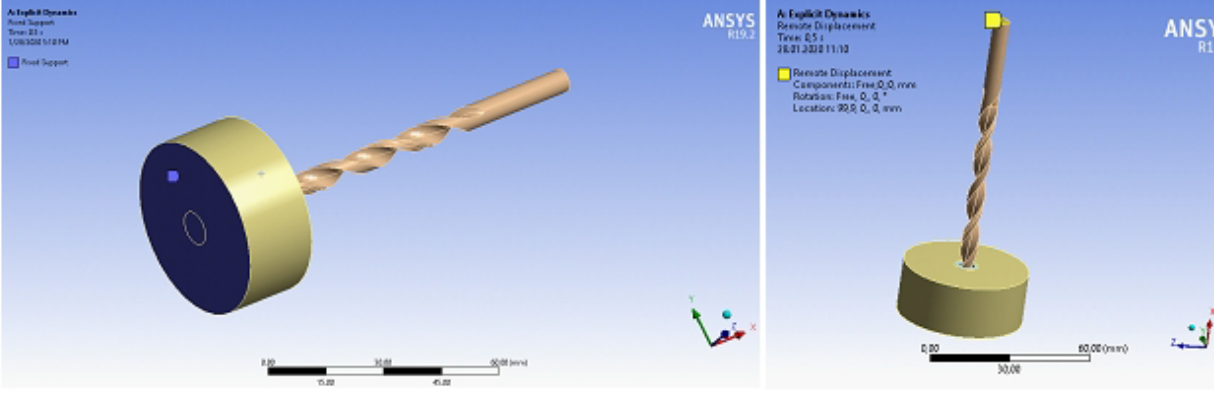
Figure 31. Ansys definition of the boundary conditions.